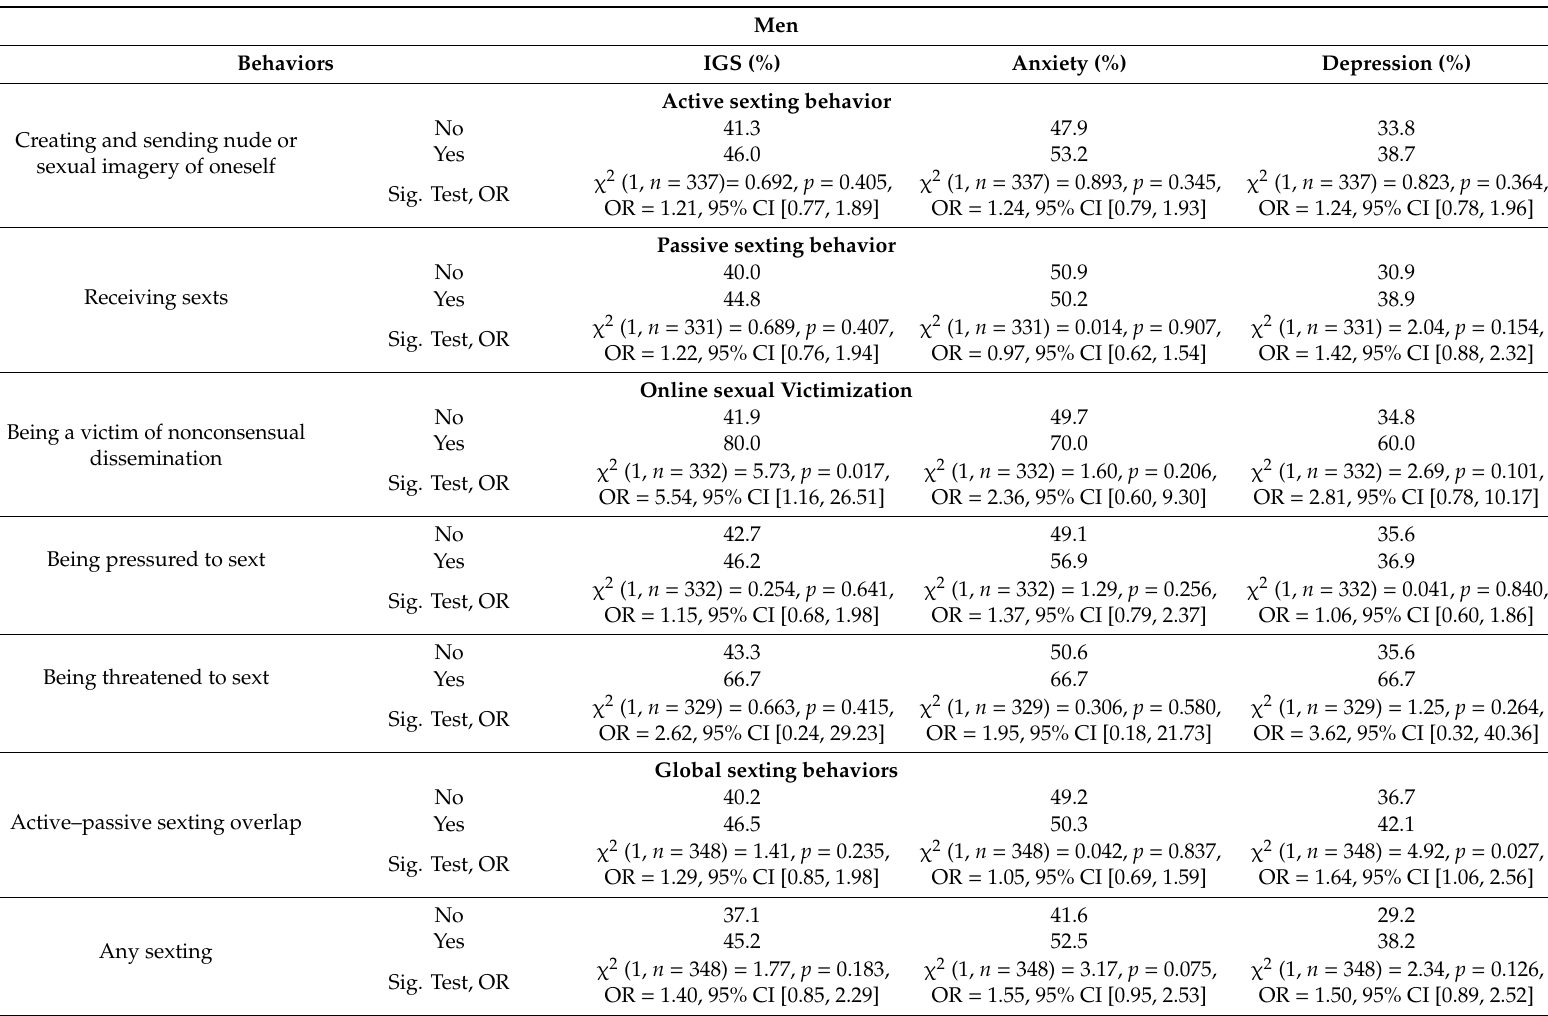
Table 5. Prevalence of psychopathology by sexting behaviors and online sexual